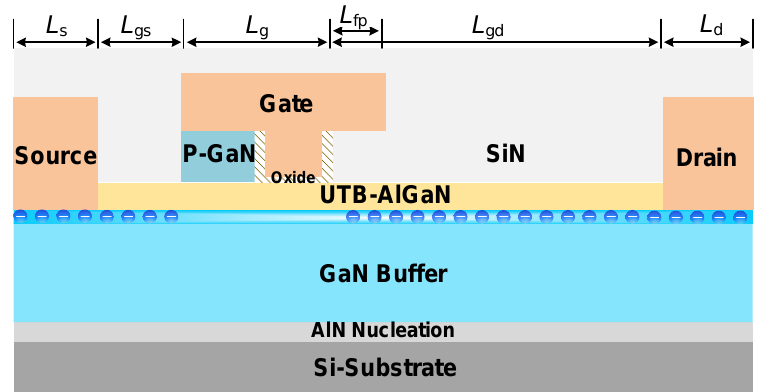
Figure 1. Schematic cross-sectional structure of the HG-UTB HEMTs.